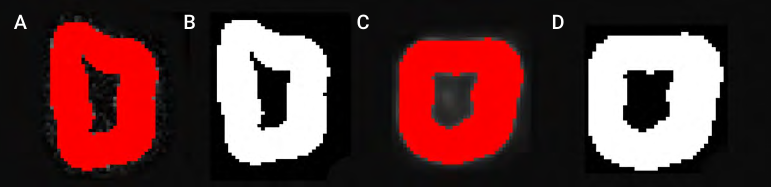
Figure 2. Image segmentation process before and after a binarization. Non-binarized micro-computed tomography image (A); binarized micro-computed tomography image (B); non-binarized Cone beam computed tomography image (C); binarized Cone beam computed tomography image (D).